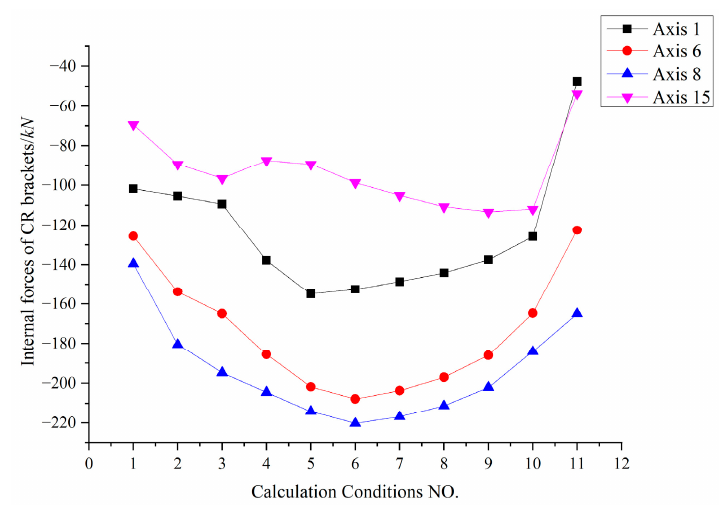
Figure 27. Variation curve of traction force during traction lifting. Figures 28 and 29 show internal force curves for four selected groups of CR brackets. From C1 to C6, due to the partial lifting of the cable net and the eccentric force on the CR, the internal forces of the inner supports at 45 ◦ gradually increase and those of the outer supports gradually decrease. From C6 to C11, all cables start to be lifted together. At this time, the eccentric force decreases and the internal forces are gradually distributed evenly. Notably, all supports remain under pressure during the whole traction lifting process, indicating that local torsion of the CR does not occur.